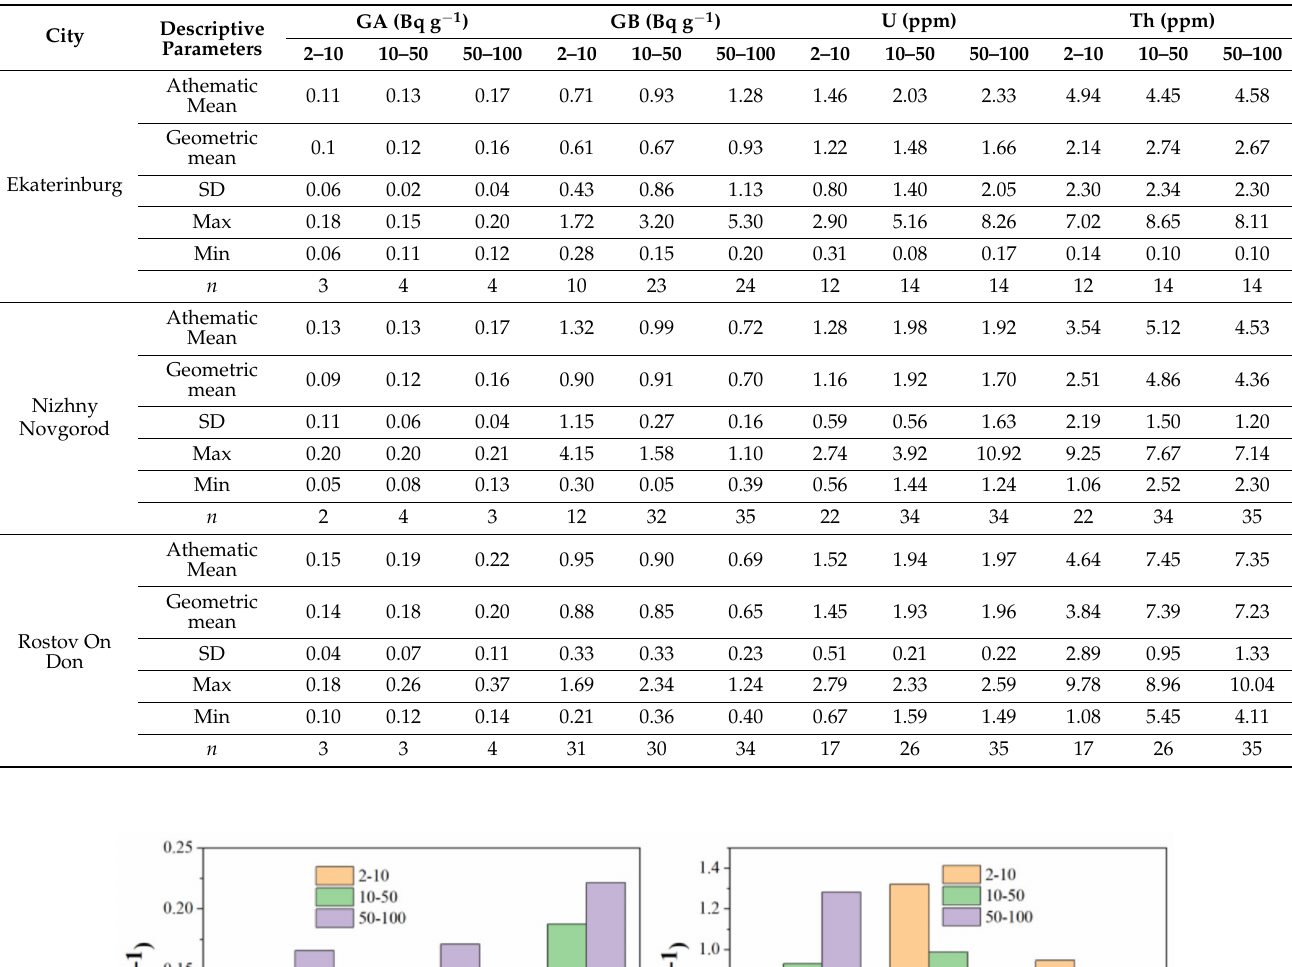
Table 2. Descriptive statistics for the gross alpha activity concentration (GA), gross beta activity concentration (GB), U content (ppm) and Th content (ppm) in the USDS size fractions ( µ m).